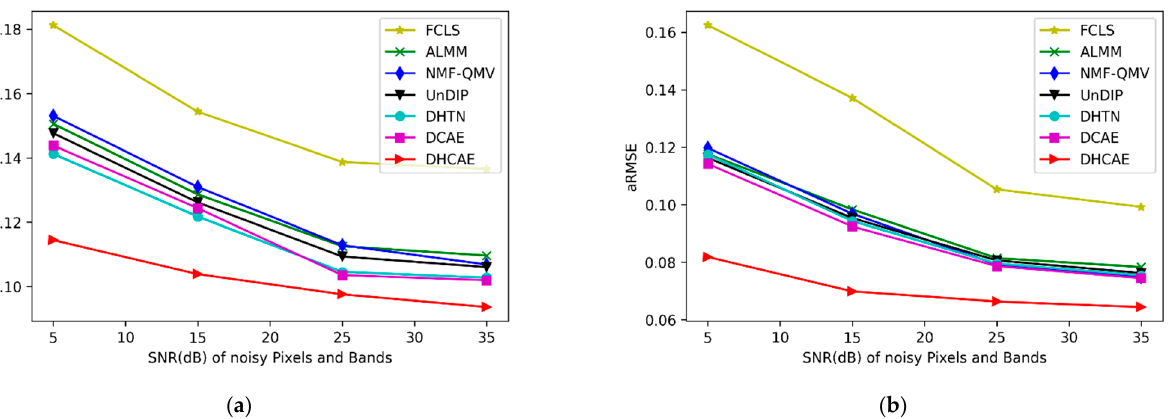
Figure 7. Robustness evaluation of the unmixing methods with various pixel and band noise levels. ( a ) aSAM. ( b ) aRMSE.